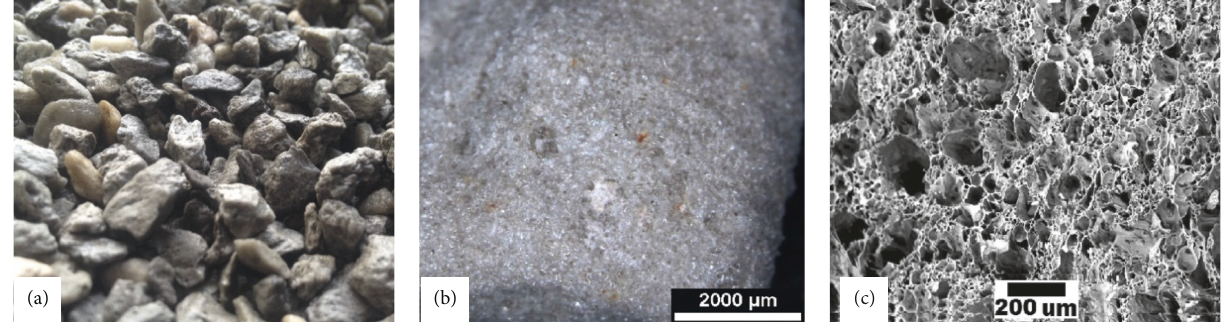
Figure 2: LWA perlite: (a) real scale; (b) micrograph to 32x and (c) SEM micrograph to 500x.